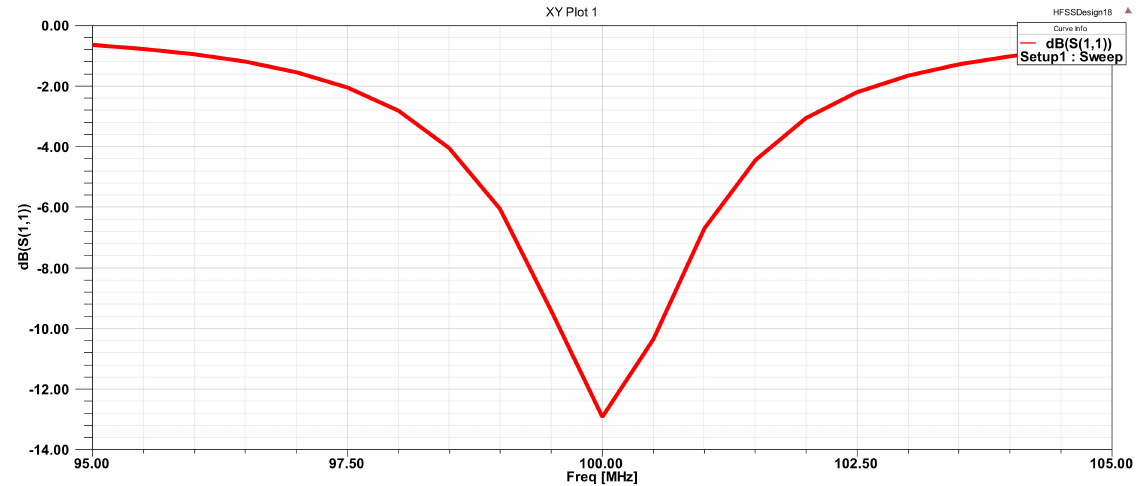
Figure 7. Parametric curve of central frequency point S11. Determination of the D value (unit spacing): In Figure 8, at the central frequency point of 100 MHz, the red line is the S11 parametric curve at D = 16 mm, the green line is the S11 parameter curve when D = 20 mm, and the blue line is the S11 parameter curve when D = 25 mm. Three parametric curves for different spacings were compared. When D = 16 mm, the S11 value of the parametric curves was the smallest; S11 = − 12.6 dB. At this point, S11 was between 0 and − 20 dB. Generally, the closer the S11 parameter was to − 20 dB, the smaller the return loss of the probe. Figure 9 shows three VSWR parameter curves with different D spacings. At the center frequency point of 100 MHz, VSWR = 1.5896 when D = 16 mm, VSWR = 1.5901 when D = 20 mm, and VSWR = 1.6025 when D = 25